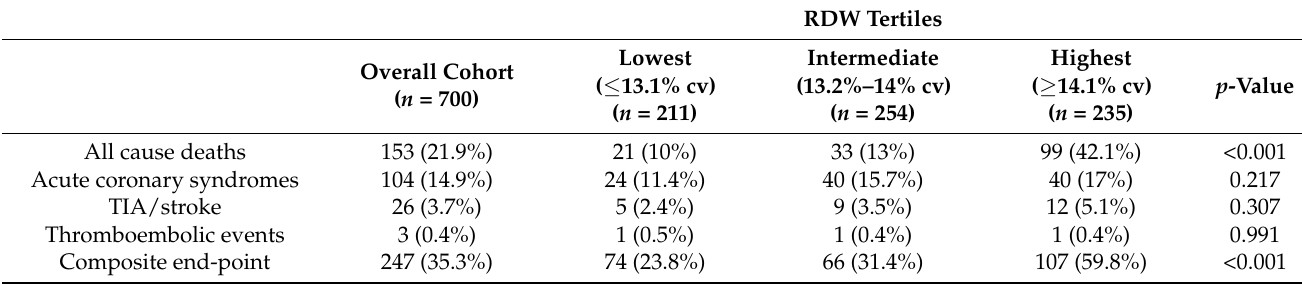
Table 2. Major adverse clinical events during the